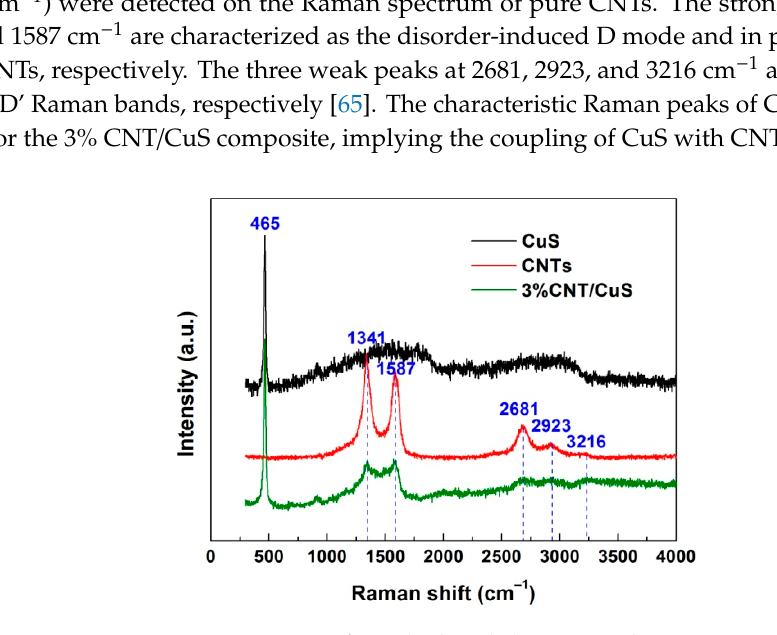
Figure 8. FTIR spectra of CuS (12 h-20 °C), CNTs and 3% CNT/CuS.